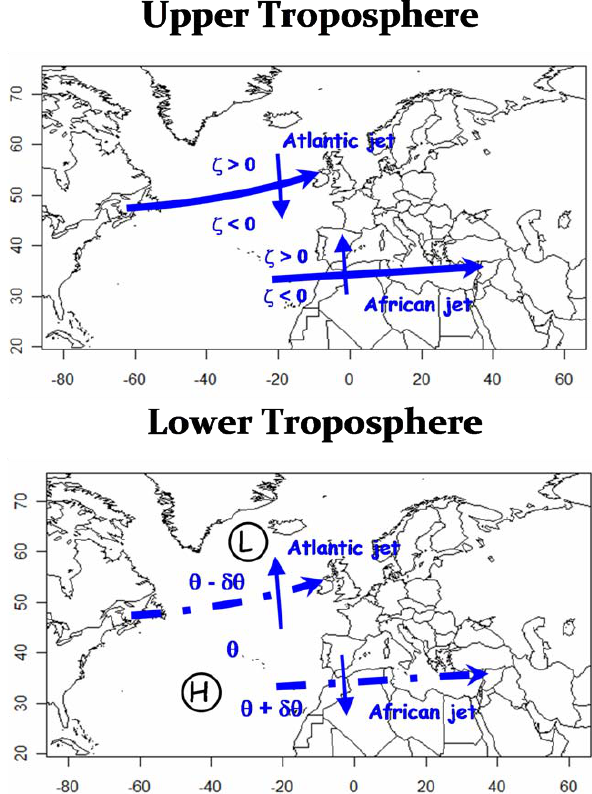
Fig. 4. Conceptual picture of the vorticity and thermal advections driven by the cross-jet circulations in the exit region of the Atlantic jet and in the entrance region of the African